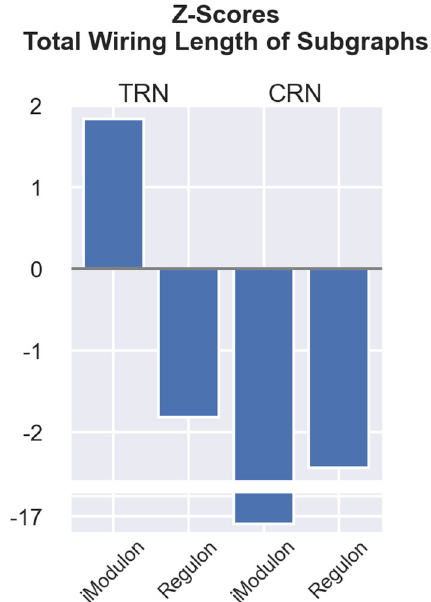
Fig. 5 Comparison of total wiring lengths for iModulon and Regulon subgraphs in the TRN and CRN. We calculate the wiring lengths of iModulon/Regulon subgraphs as the sum of wiring lengths for all edges between the nodes in the subgraphs, ensuring that the main regulators are in the considered subgraphs (The main regulator(s) is added to the subgraph if it is not one of the nodes in the considered subgraph.). The total wiring length is the sum of the wiring lengths of all iModulon/Regulon subgraphs in the TRN/CRN. For the z-scores listed here, we employ the network compiled in the original iModulon publication 36 and generate 1000 randomized networks using the node swap method (see Methods).